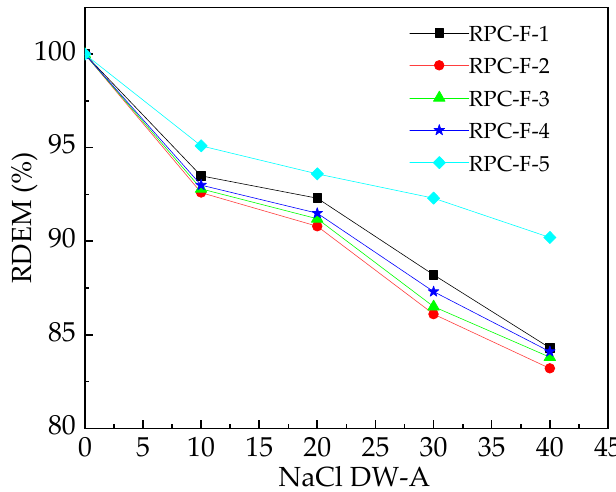
Figure 10. The RDEM of RPC during NaCl DW-A.